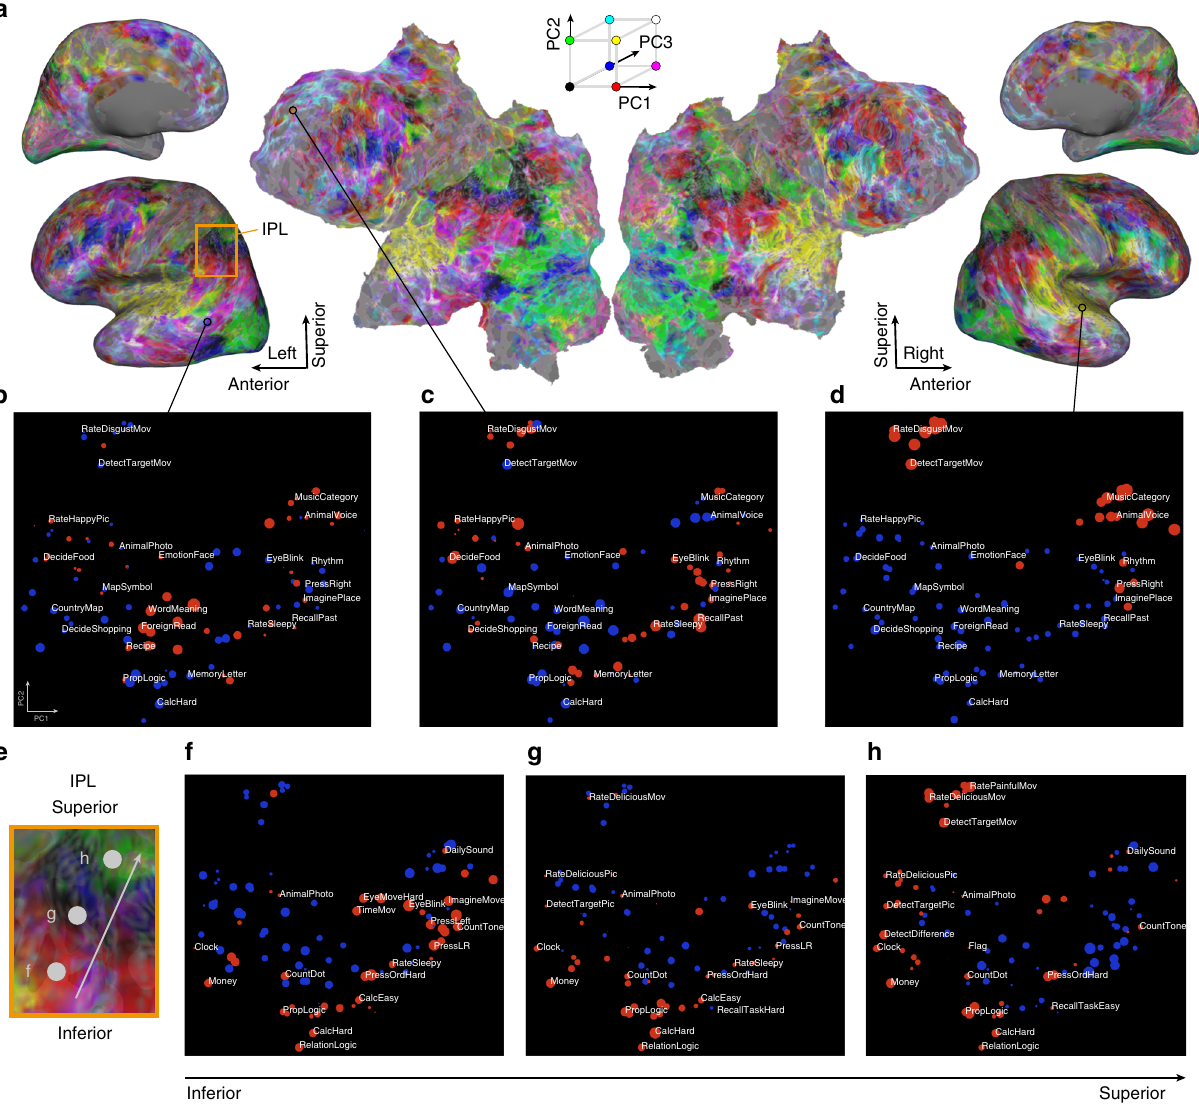
Fig. 4 Cognitive space and cortical mapping. a The cortical map of the cognitive space shown on the in fl ated and fl attened cortical sheets of subject ID01 (Supplementary Fig. 5 shows all other subjects); PC1 – PC3 are shown in red, green, and blue, respectively. b – d Examples of the task selectivity for voxels in the b left middle temporal, c left medial frontal, and d right superior temporal regions, mapped onto the two-dimensional cognitive space based on the loadings of the fi rst and second principal components (PC1 and PC2, respectively) of the model weights. Tasks with positive and negative weight values were denoted in red and blue, respectively. The circle size was modulated based on the absolute weight value. For better visibility, only 24 tasks are shown in white. e The left inferior parietal lobule (IPL) corresponding to the orange square part in the in fl ated cortical sheet ( a ). f – h Three voxels along with the inferior to superior direction were selected to show the topographic change of task selectivity. For better visibility, only 18 tasks with positive weight values are shown in